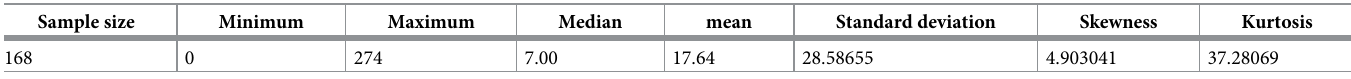
Table 2. Statistical description of data